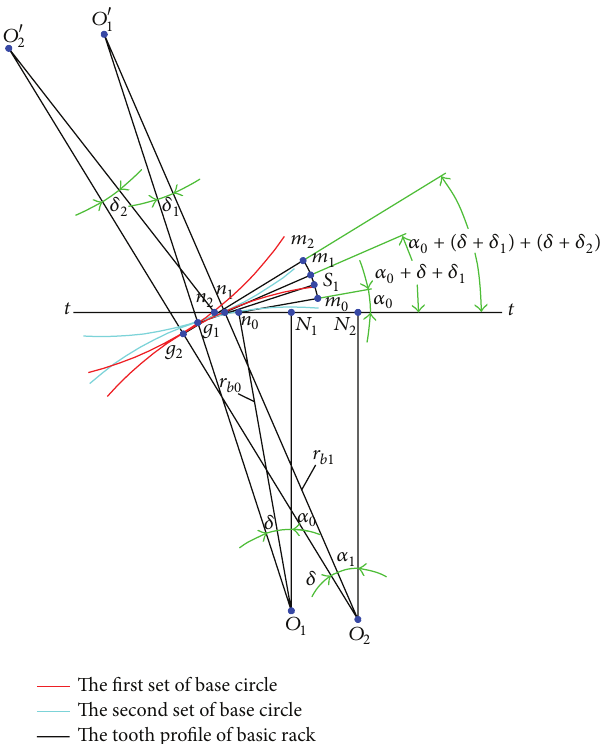
Figure 1: The principle of microsegment gear tooth profile.